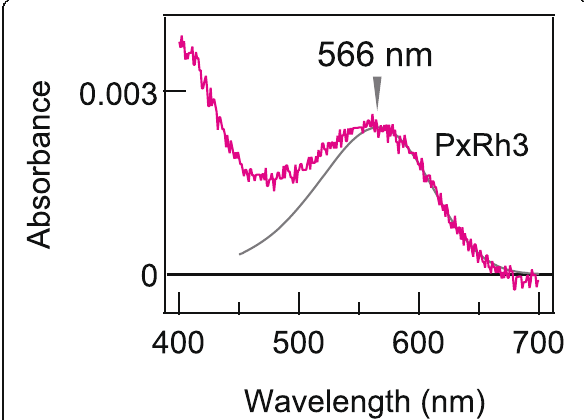
Fig. 1 Absorption spectrum of a butterfly LWS opsin. Absorption spectra of purified PxRh3 WT (magenta). An estimated sensitivity curve of PxRh3 (grey curve) was obtained by fitting PxRh3 spectra with rhodopsin nomogram. Wavelength of maximum sensitivity of PxRh3 is estimated to 566 nm (grey